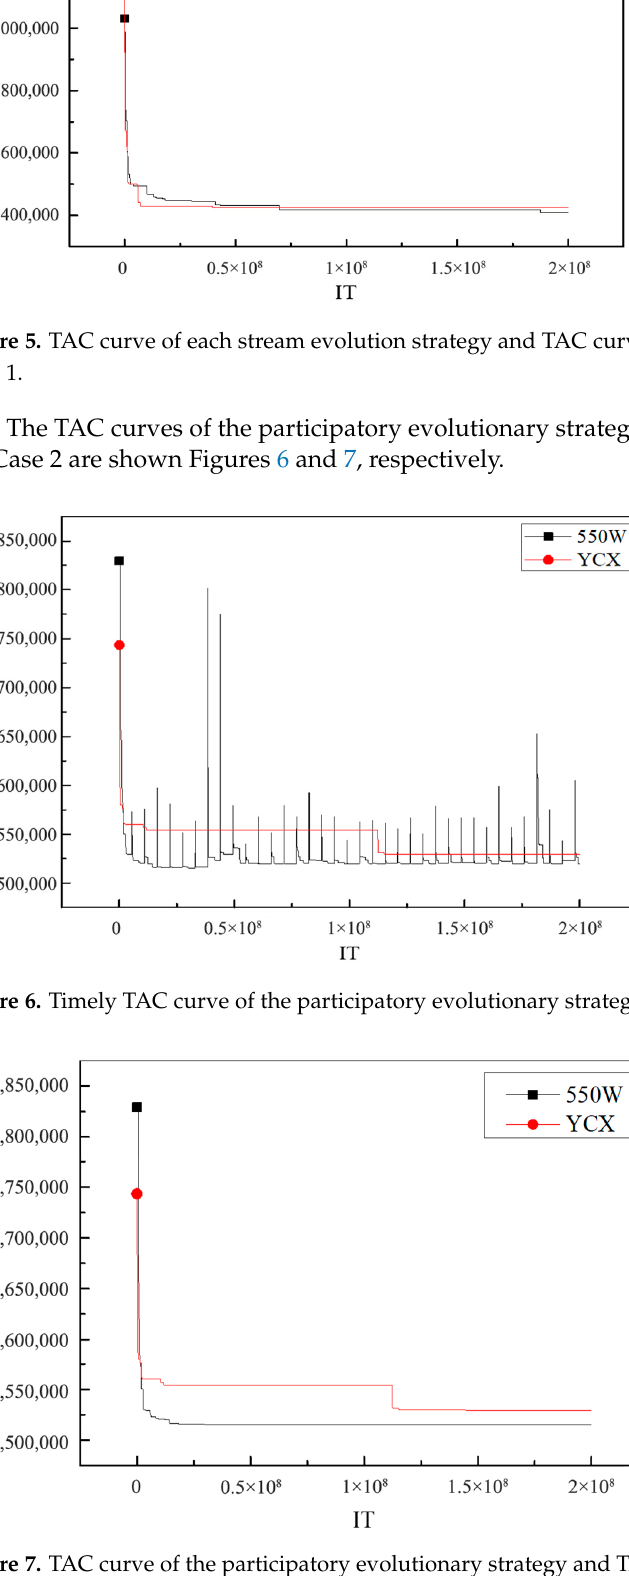
Figure 4. Timely TAC curve and the best TAC curve obtained through the participatory evolution- ary strategy.